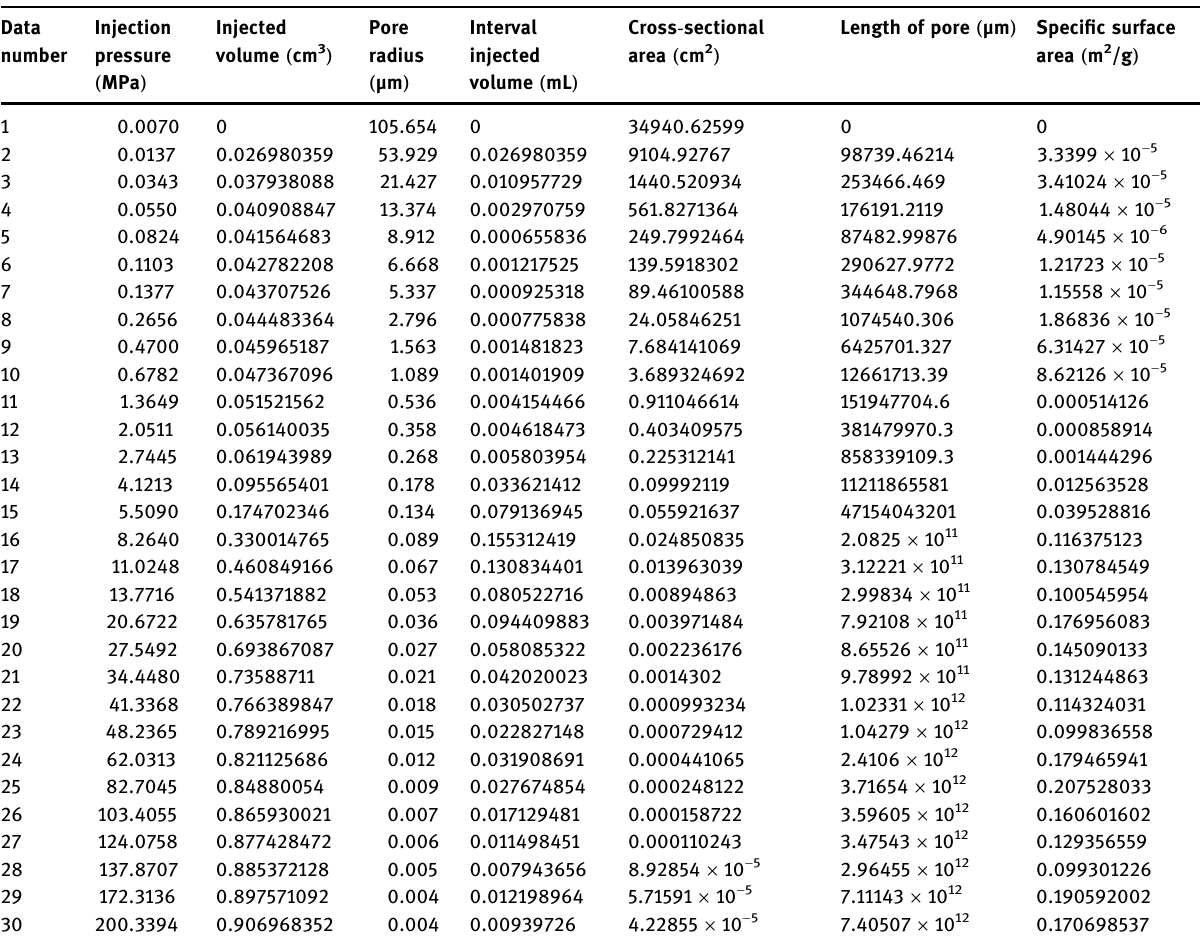
Table 1: Speci fi c surface area data obtained from mercury intrusion experiment